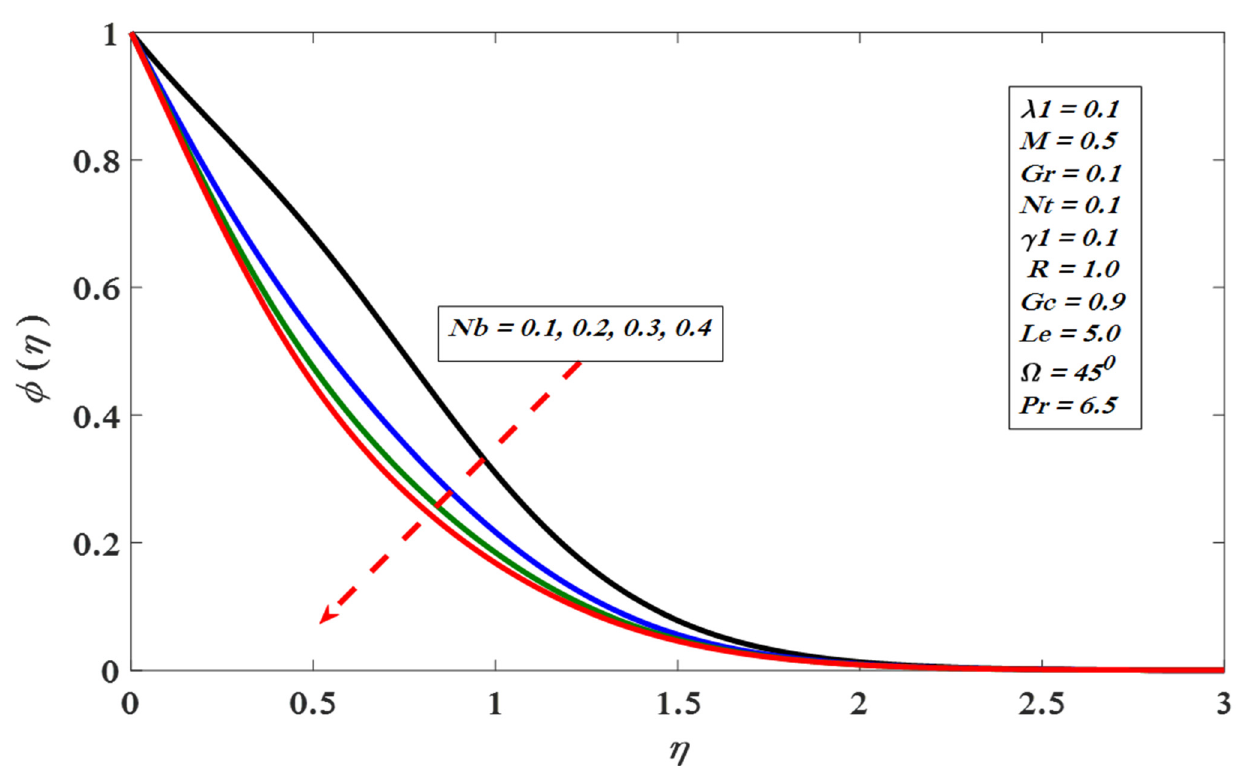
Figure 14. Concentration profile versus . Le